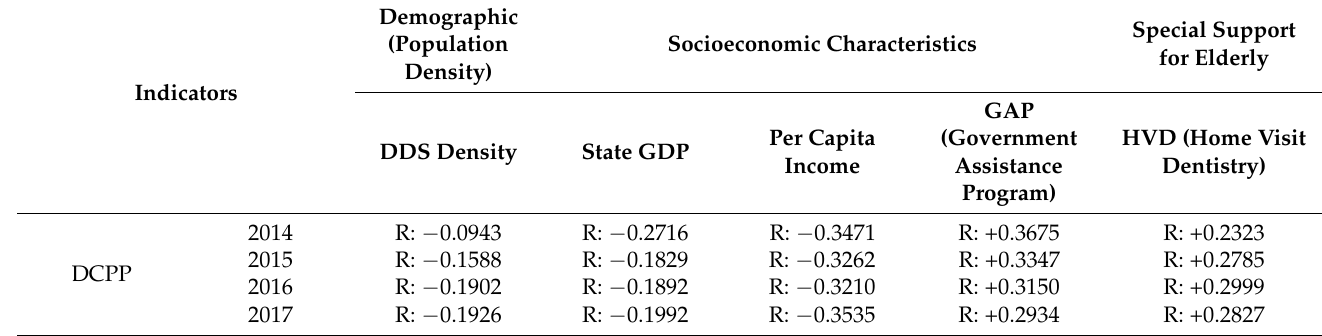
Table 2. Association between demographic and socioeconomic characteristics and